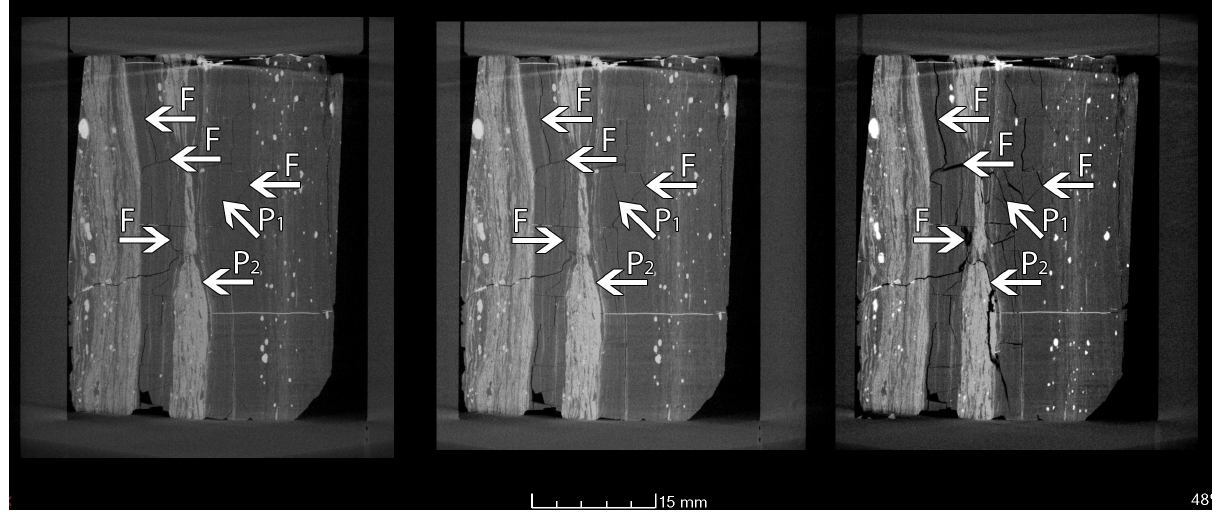
F indicates cleats or cracks that existed in the pre-loaded particles that enlarged during compression; P indicates either maceral–maceral boundaries or maceral–mineral boundaries that may have had an influence on crack initiation. Figure 5: Comparison of a particle before (left) and after (right) compression incrementally parallel to the bedding